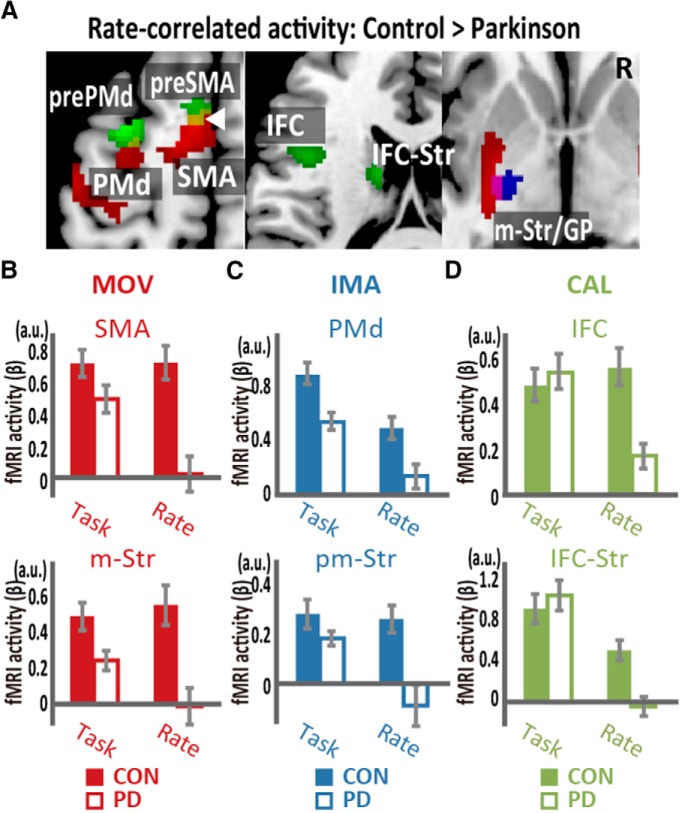
Comparison of rate-correlated activity between participants with PD and controls (CON). A, Participants with PD showed reduced rate-correlated activity in the SMA, PMd, and motor striatum/globus pallidus (m-Str/GP) for the movement task (MOV, red), in the mStr/GP for the imagery task (IMA, blue), and in the IFC, pre-SMA, pre-PMd, and a part of the IFC-connected caudate head (IFC-Str) for the calculation task (CAL, green). The yellow region (indicated by white arrowhead) represents the limited overlaps of the reduced activity between the calculation rate-correlated activity and movement rate-correlated activity. B, The task-related and rate-correlated fMRI activities (β) in the SMA and m-Str are shown for the two groups during the movement task. C, Task-related and rate-correlated fMRI activities in the PMd and pm-Str during the imagery task. D, Task-related and rate-correlated fMRI activities in the IFC and IFC-Str during the calculation task.